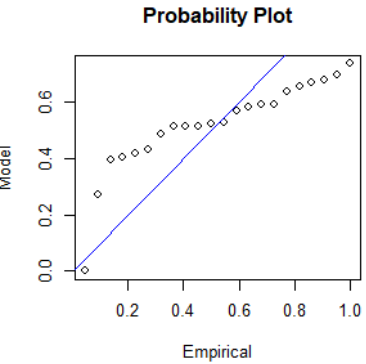
Figure 11. The probability plot for the AM/Gumbel method at location S1.